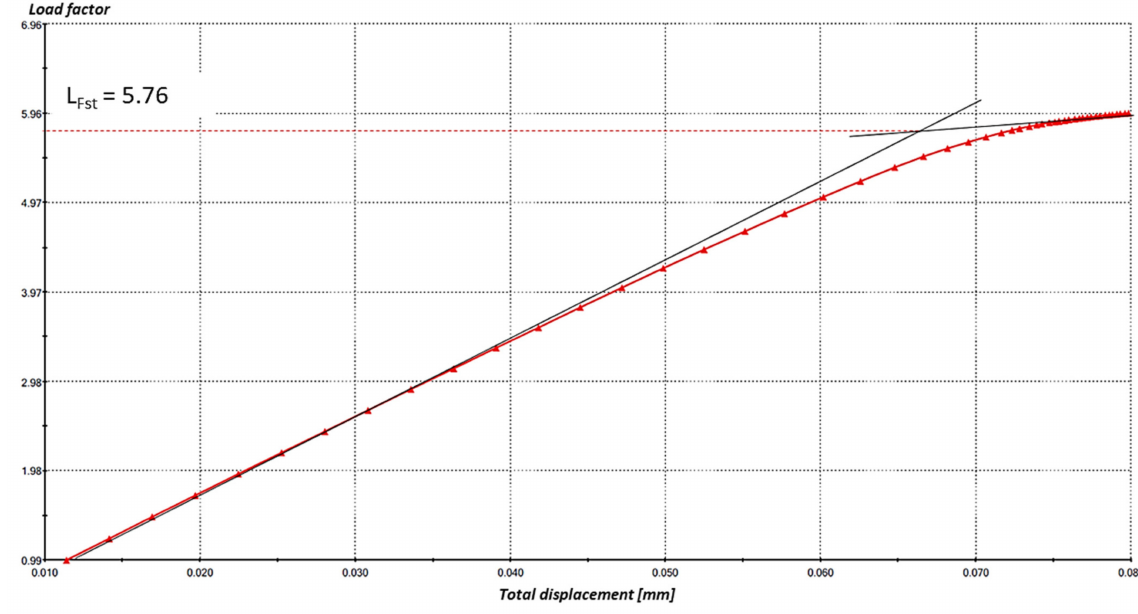
Figure 15. Load characteristics at the node 37